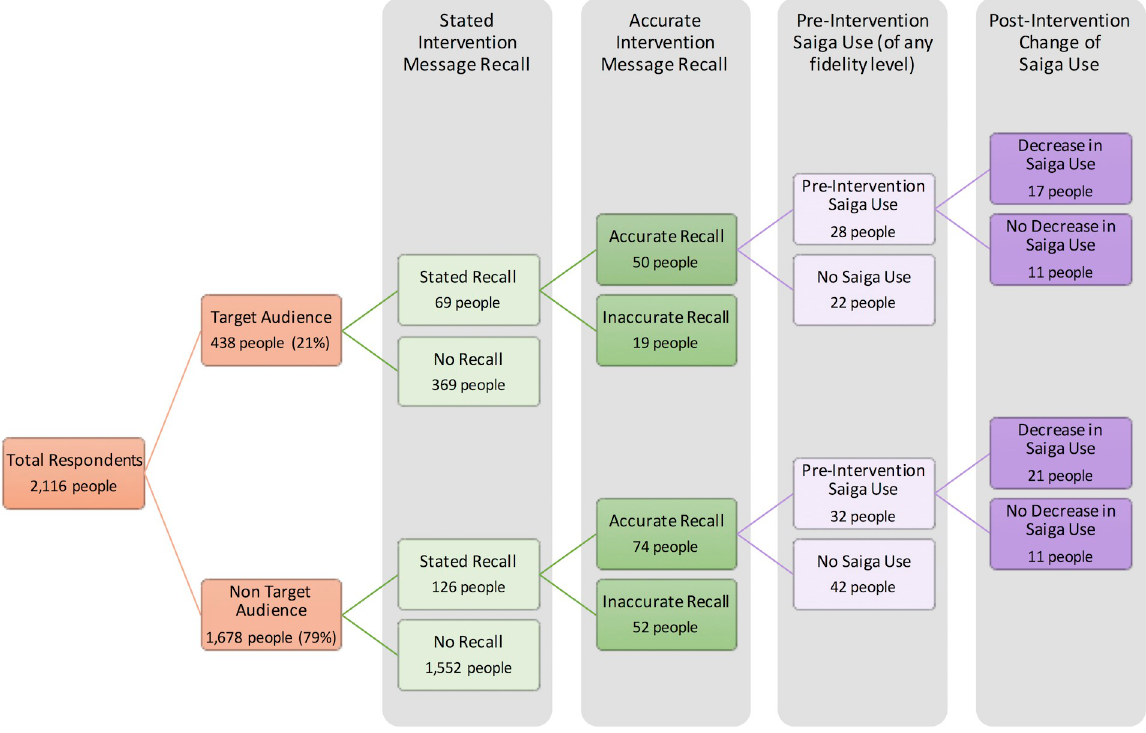
Fig 5. A funnel of consumer survey respondents from the total sample through till stated decrease in saiga horn usage following the intervention. Colours correspond to the Theory of Change stages outlined in Fig 1.